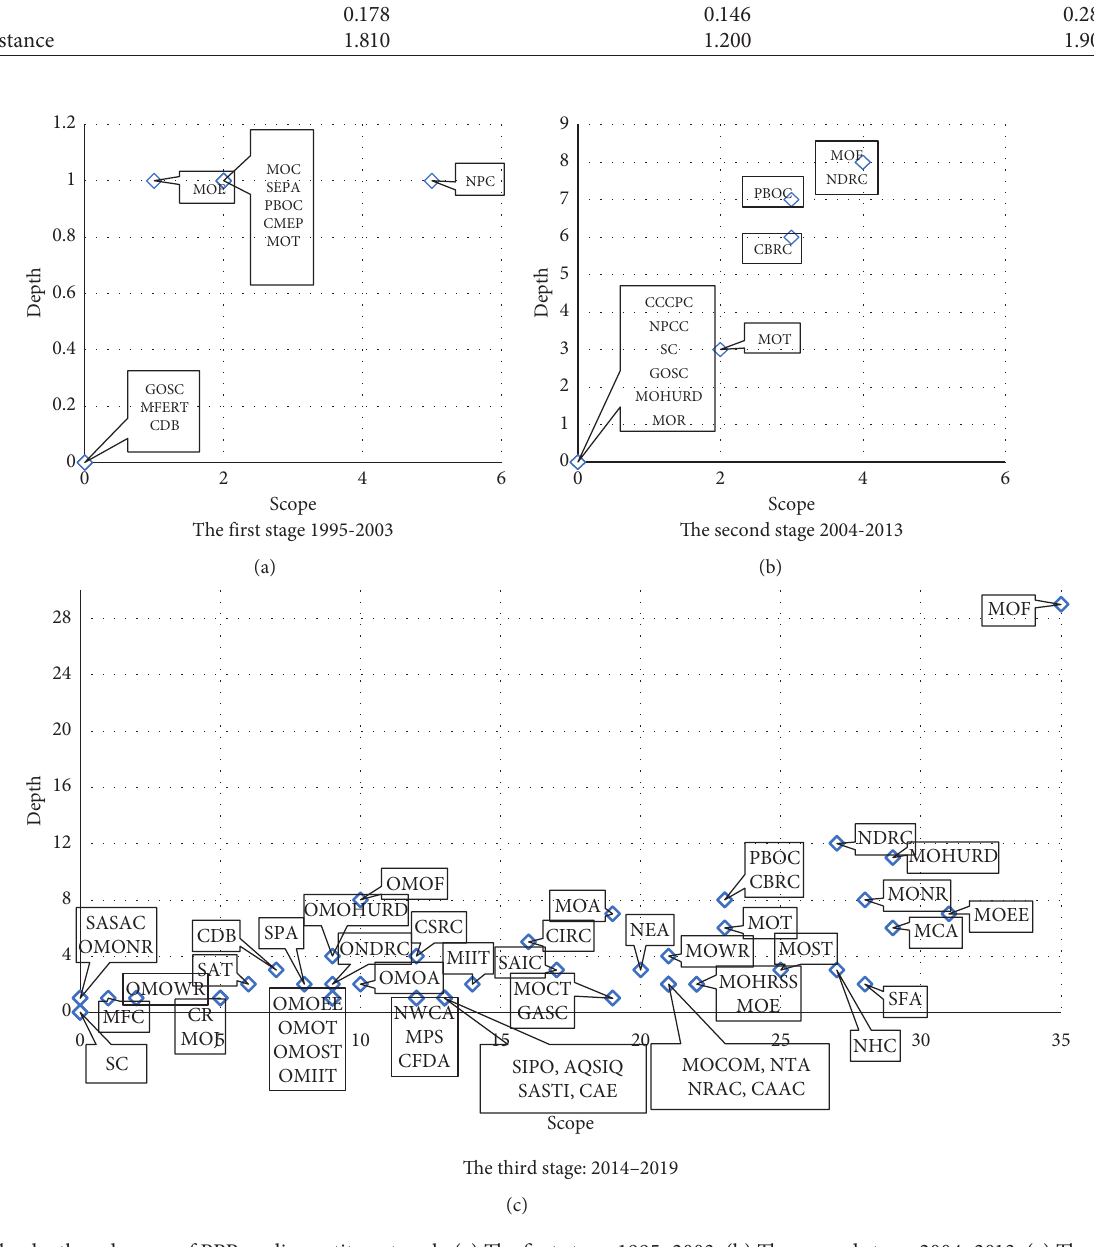
Figure 4: The depth and scope of PPPs policy entity network. (a) The first stage: 1995–2003. (b) The second stage: 2004–2013. (c) The third stage: 2014–2019.